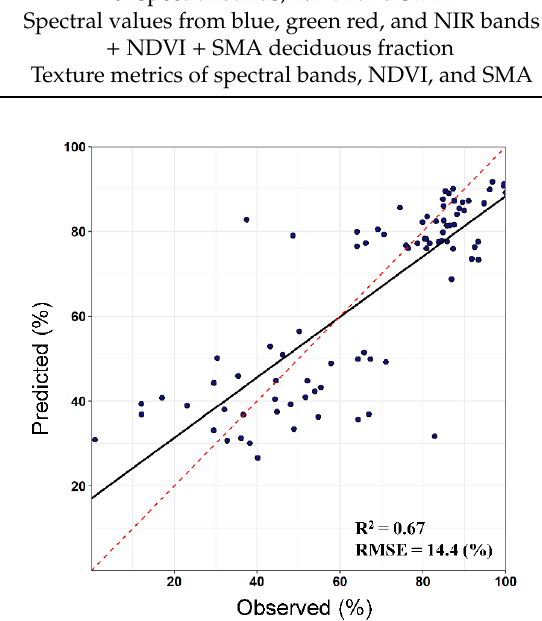
Figure 2. Model validation analyses of the best-fitted model for predicting tree species deciduousness. The graph shows predicted versus observed tree species deciduousness. The dashed red line shows 1:1 reference line and the bold line is the regression line.